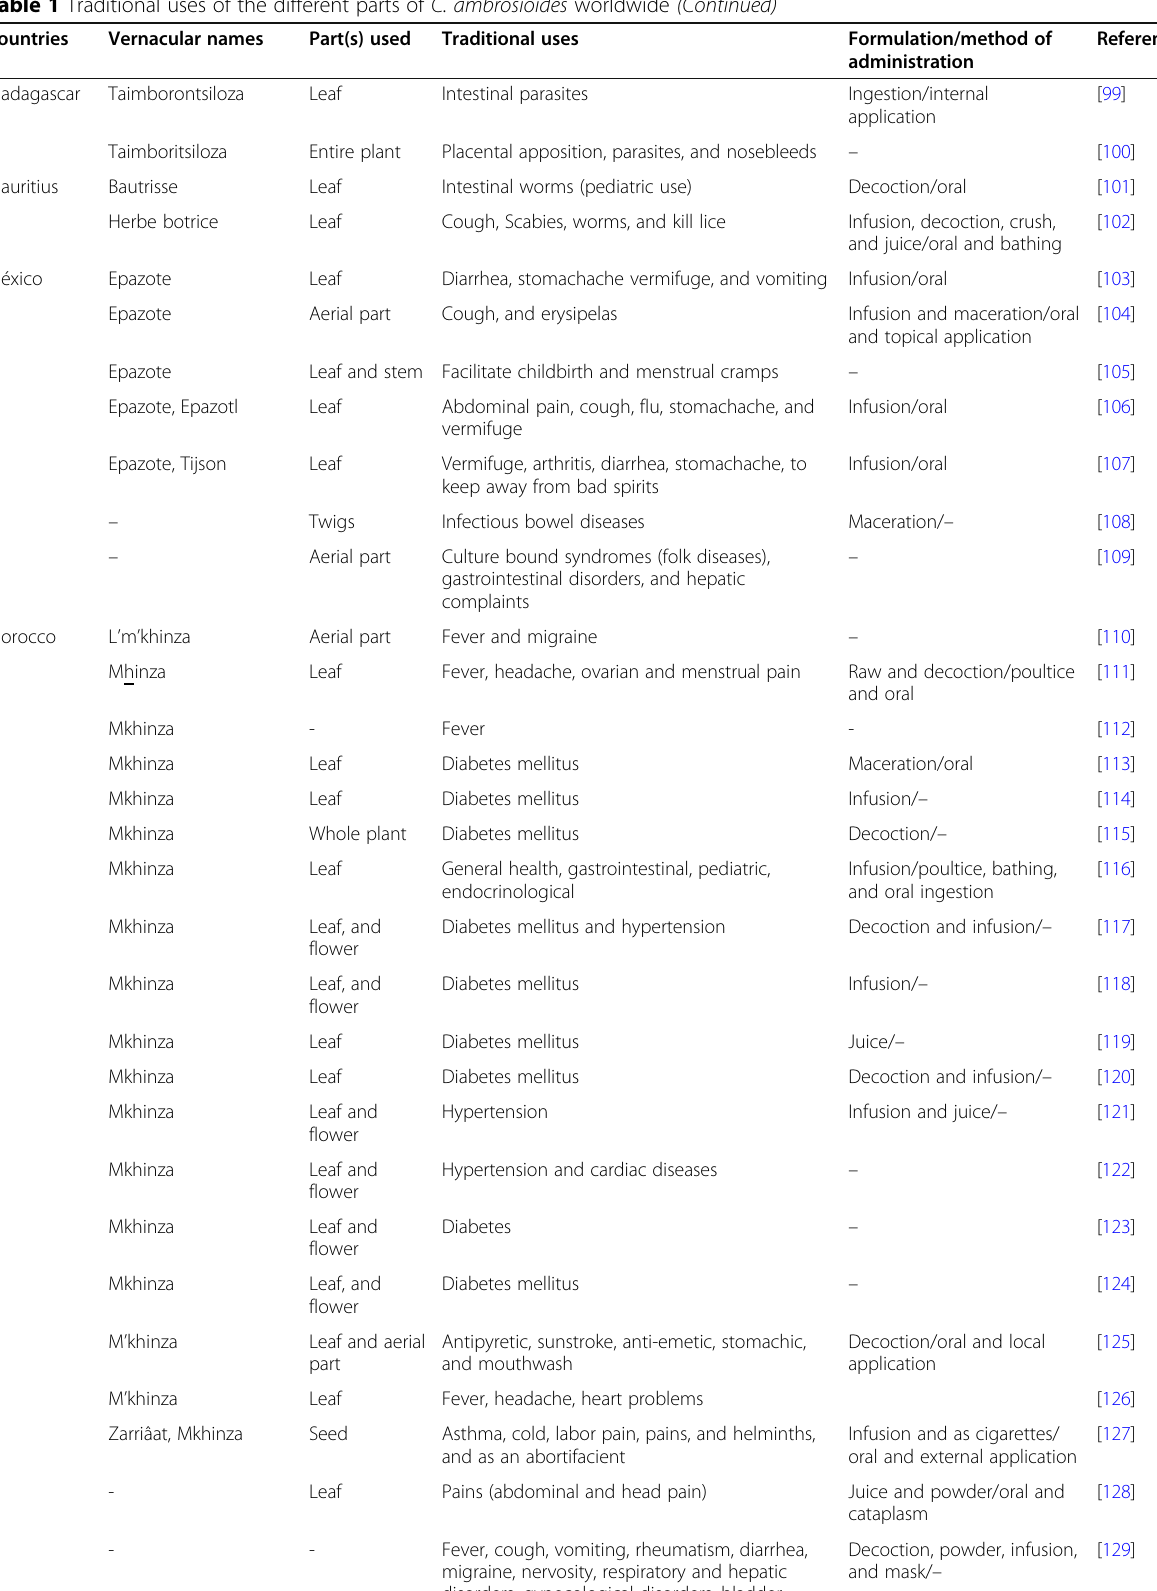
Table 1 Traditional uses of the different parts of C. ambrosioides worldwide